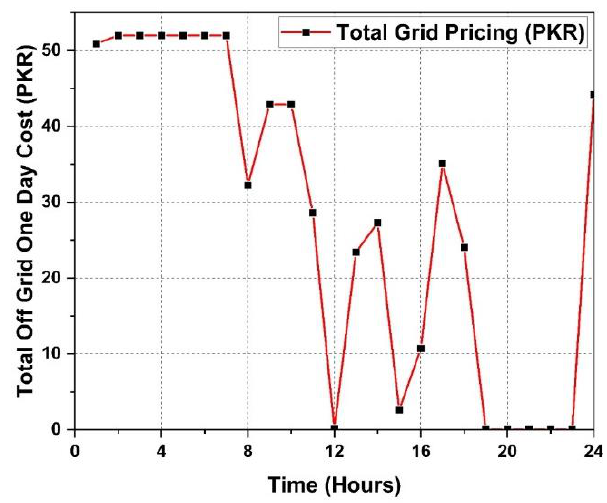
Figure 13. Off − grid costing for one day.